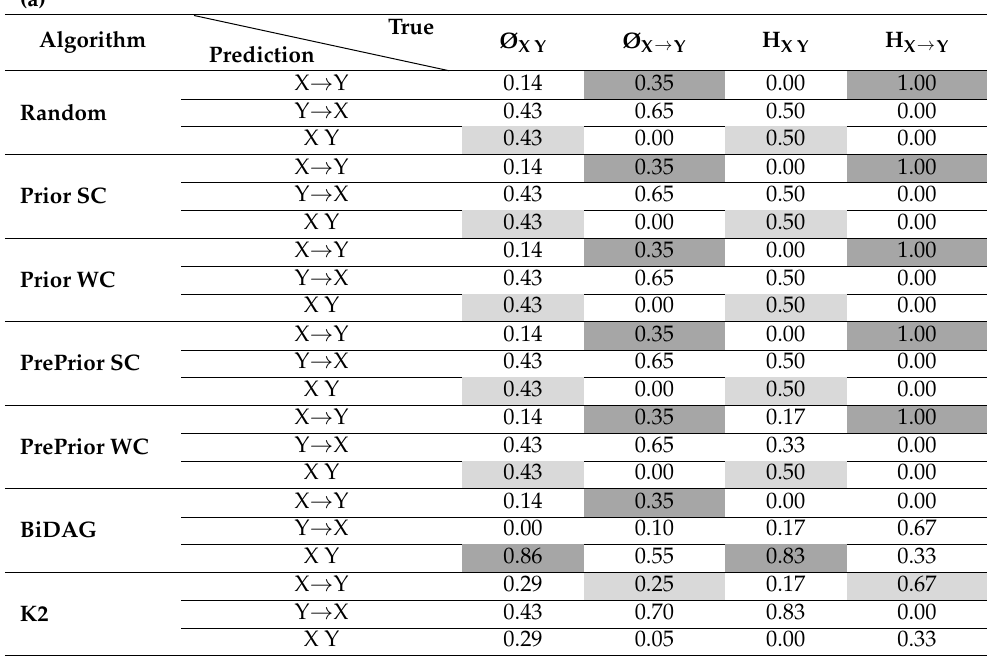
Table 10. Algorithms’ most probable prediction rates by four causal pairwise relationships without the order weight. (a) Dataset for Sparse 9 variable with 50 cases (D50S9). Dark shaded cells represent the best prediction of the correct causal relationship; Bright shaded cells represent the second best prediction of the correct causal relationship. (b) Dataset for Close 9 variable with 50 cases (D50C9). Dark shaded cells represent the best prediction of the correct causal relationship; Bright shaded cells represent the second best prediction of the correct causal relationship. (c) Dataset for Sparse 9 variable with 1000 cases (D1KS9). Dark shaded cells represent the best prediction of the correct causal relationship; Bright shaded cells represent the second best prediction of the correct causal relationship. (d) Dataset for Close 9 variable with 1000 cases (D1KC9). Dark shaded cells represent the best prediction of the correct causal relationship; Bright shaded cells represent the second best prediction of the correct causal relationship.